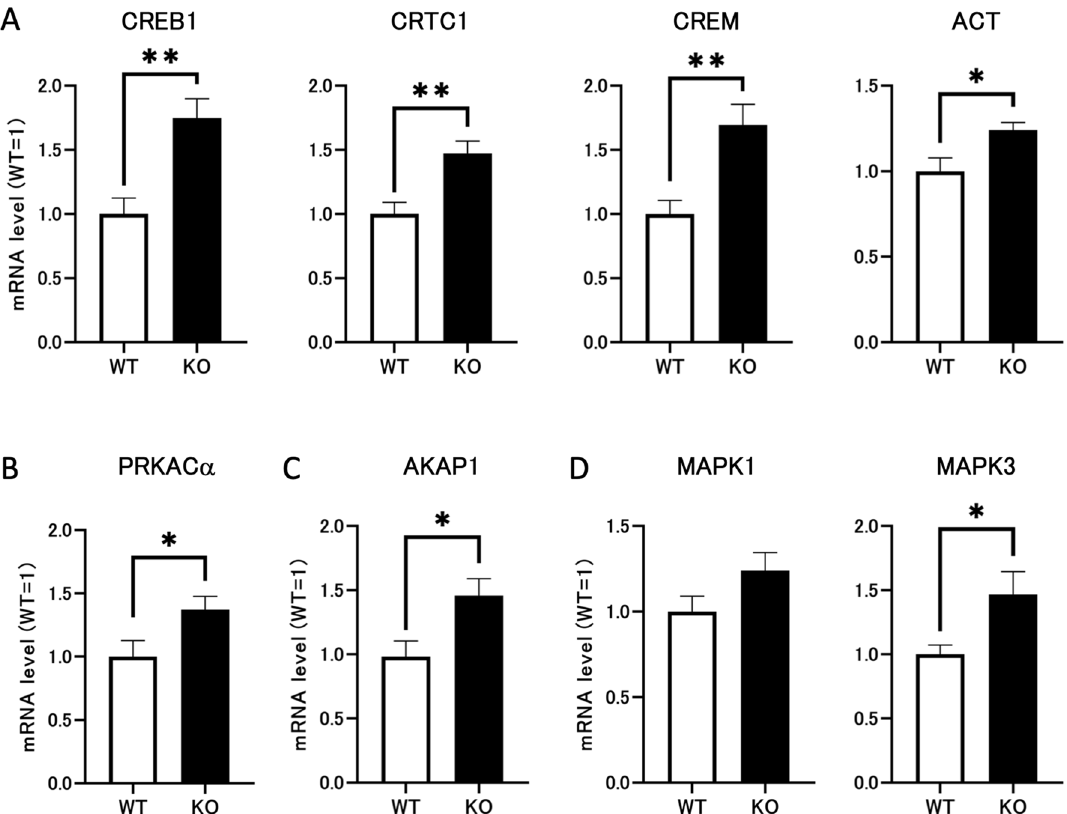
Figure 6. Effects of Dapl1 deletion on the PKA system and CREB/CREM pathway in mouse testes at PND49. ( A ) Effect of Dapl1 ablation on the testicular CREB/CREM pathway gene-expression of mRNA coding for CREB1, CRTC1, CREM, and ACT in mice at PND49. Each bar represents the mean ± S.E.M. of 9–12 mice. ( B ) Effect of Dapl1 ablation on the testicular PKA system gene-expression of mRNA coding for PRKACα in mice at PND49. Each bar represents the mean ± S.E.M. of 9–12 mice. ( C ) Effect of Dapl1 ablation on gene-expression of mRNA coding for AKAP1 in mice testes at PND49. Each bar represents the mean ± S.E.M. of 11–12 mice. ( D ) Effect of Dapl1 ablation on the testicular MAPK/ERK pathway gene-expression of mRNA coding for MAPK1 and MAPK3 in mice at PND49. Each bar represents the mean ± S.E.M. of 11–12 mice. Significantly different from the wild-type control: *p < 0.05, **p < 0.01. DAPL1 death-associated protein-like 1, CREB cyclic AMP-response element-binding protein; CREM CRE modulator protein; CRTC1 CREB regulated